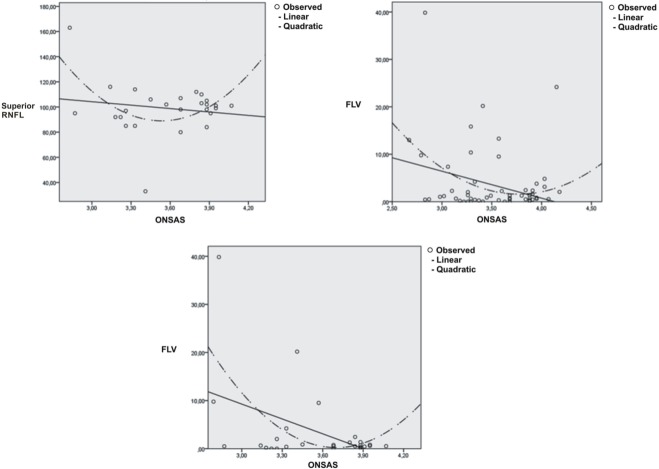
Scatter plots showing significant correlations between the optic nerve subarachnoid space (ONSAS) and superior retinal nerve fiber layer (Superior RNFL) (top left) and between ONSAS and focal loss volume (FLV) in glaucoma group 1 (top right) and between ONSAS and FLV in all glaucomatous group (bottom).